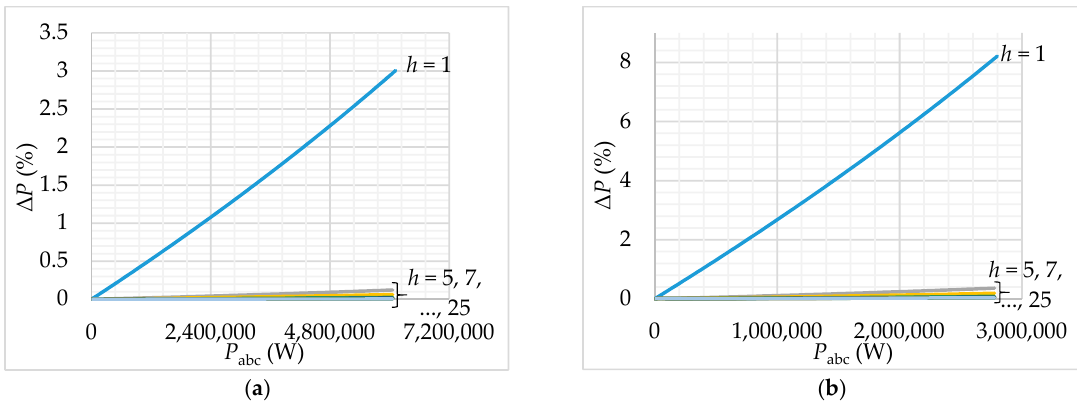
Figure 15. The dependence of increasing APLs from three-phase active power consumption for ACSR 42/7: ( a ) the length of 5 km; ( b ) the length of 30 km.